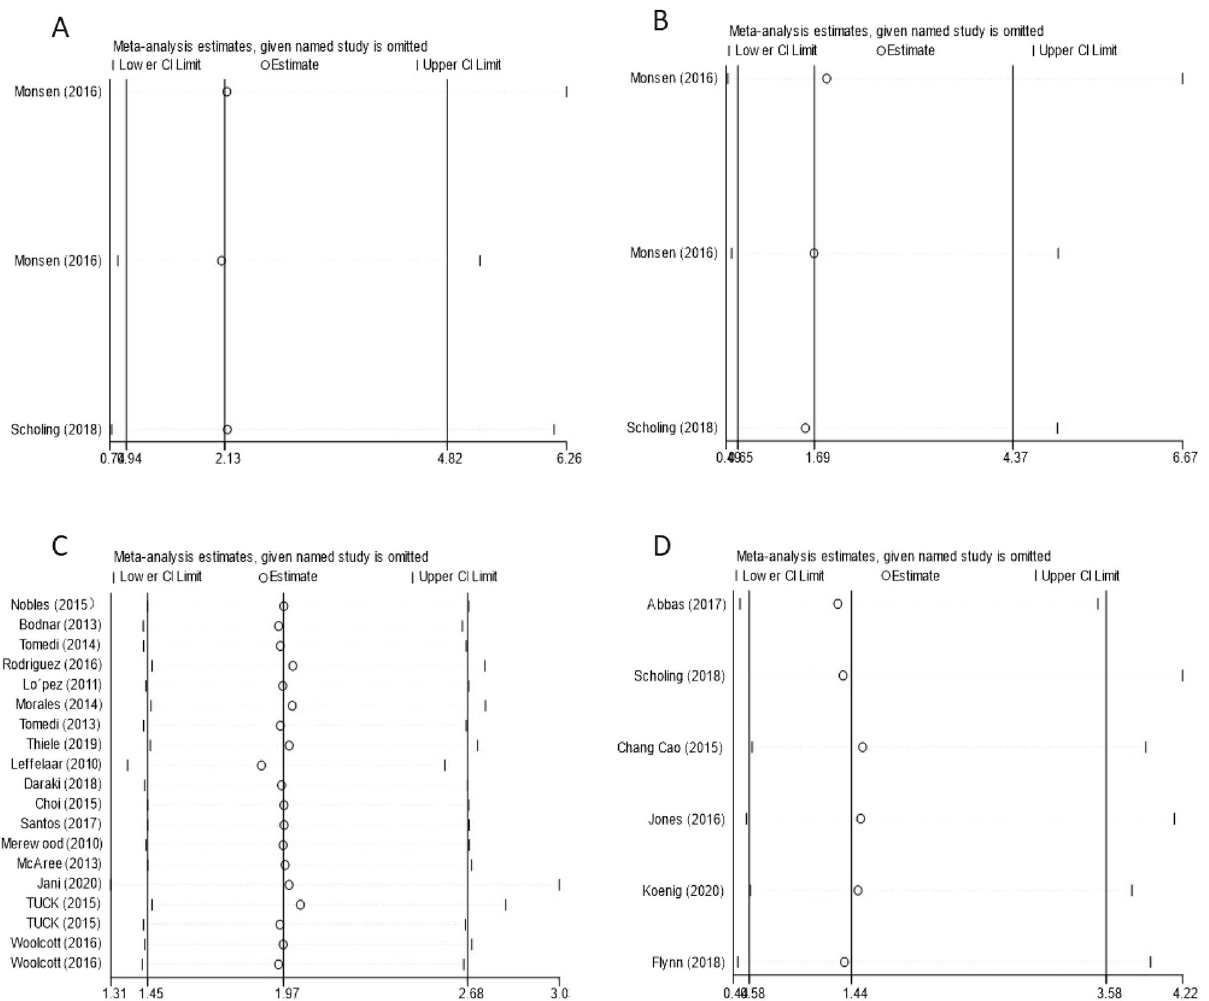
Figure 7. Sensitivity analysis between prepregnancy obesity and micronutrient deficiency, including that of vitamin B12 ( A ), folate ( B ), vitamin D ( C ), and iron ( D